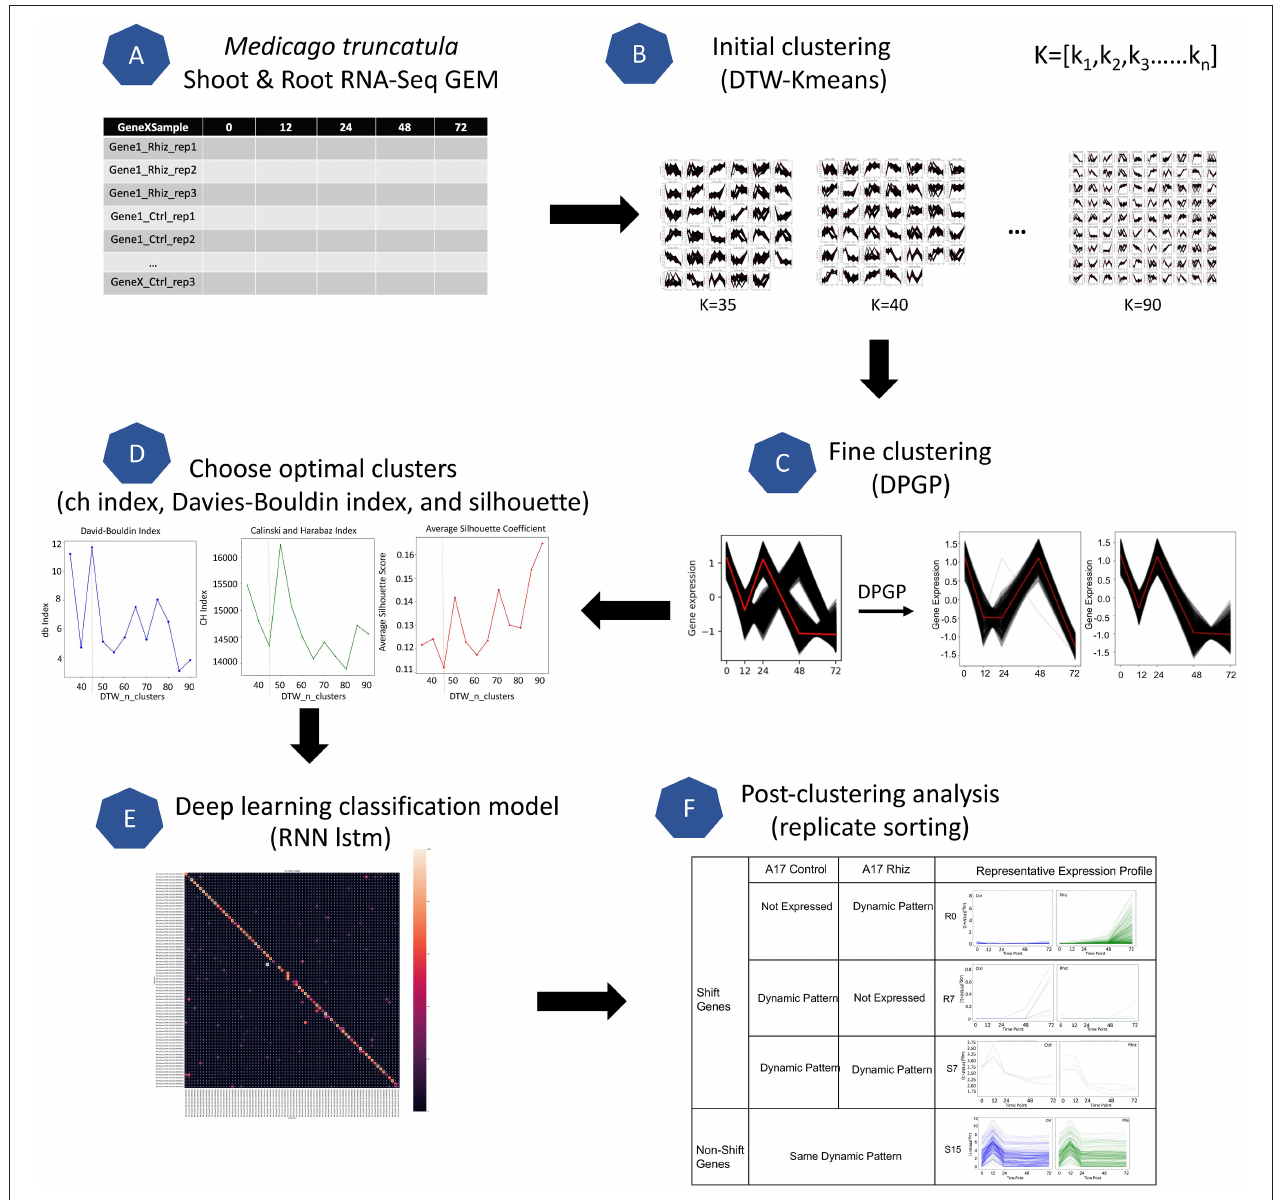
FIGURE 2 | Overview of the GeneShift workflow. Major steps of the workflow are shown in steps (A–F) . Starting with RNA-Seq data from a biological sample, GeneShift will detect gene expression pattern changes over time between two conditions. Refer to Materials and Methods for details.